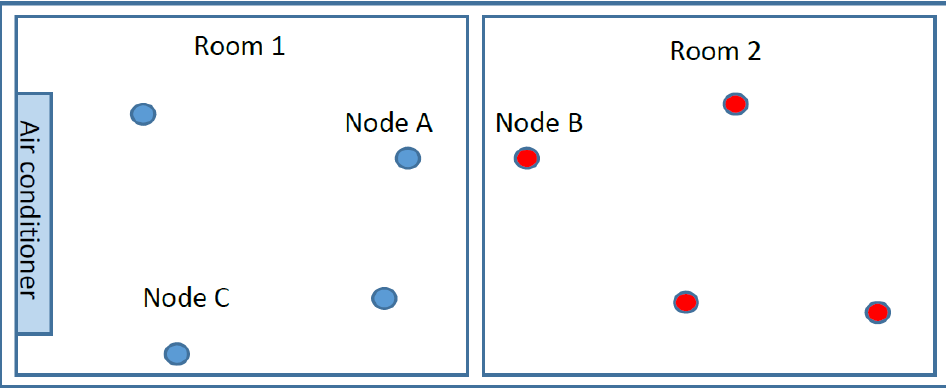
Figure 1. The layout of sensor nodes in an environment with two different conditions area.